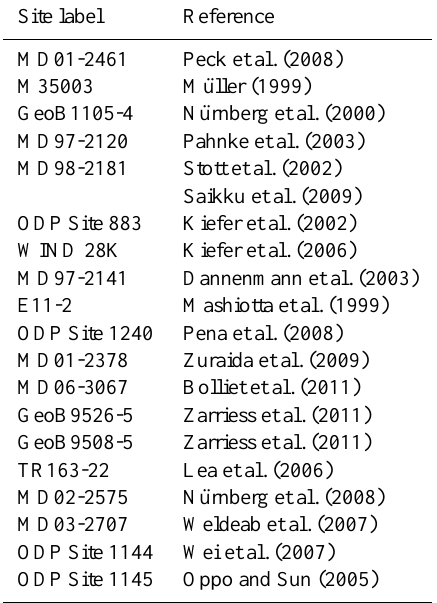
Table A4. Proxy records of SST Based on Mg/Ca included in this study. Each record is identified by the site